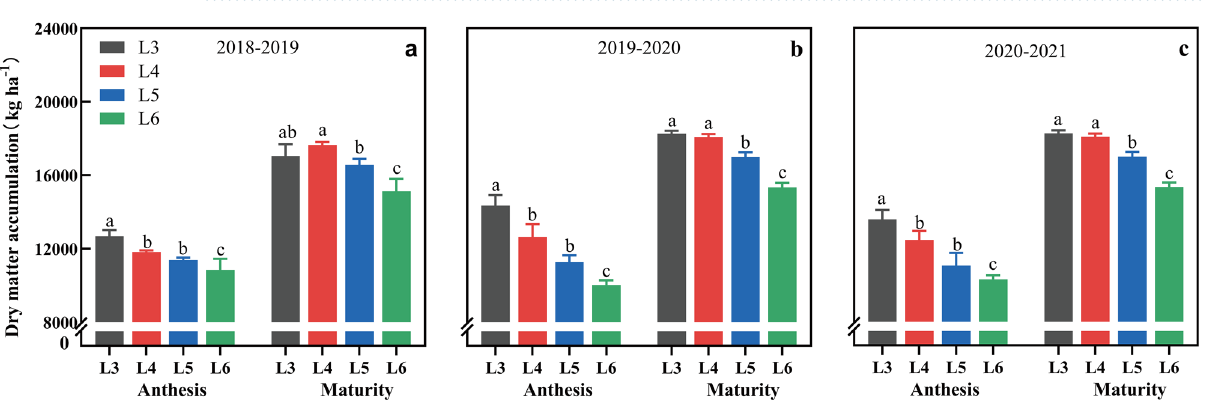
Figure 3. Effects of irrigation time on leaf area index after flowering anthesis stage in 2018–2019 ( a ), 2019– 2020 ( b ) and 2020–2021 ( c ).